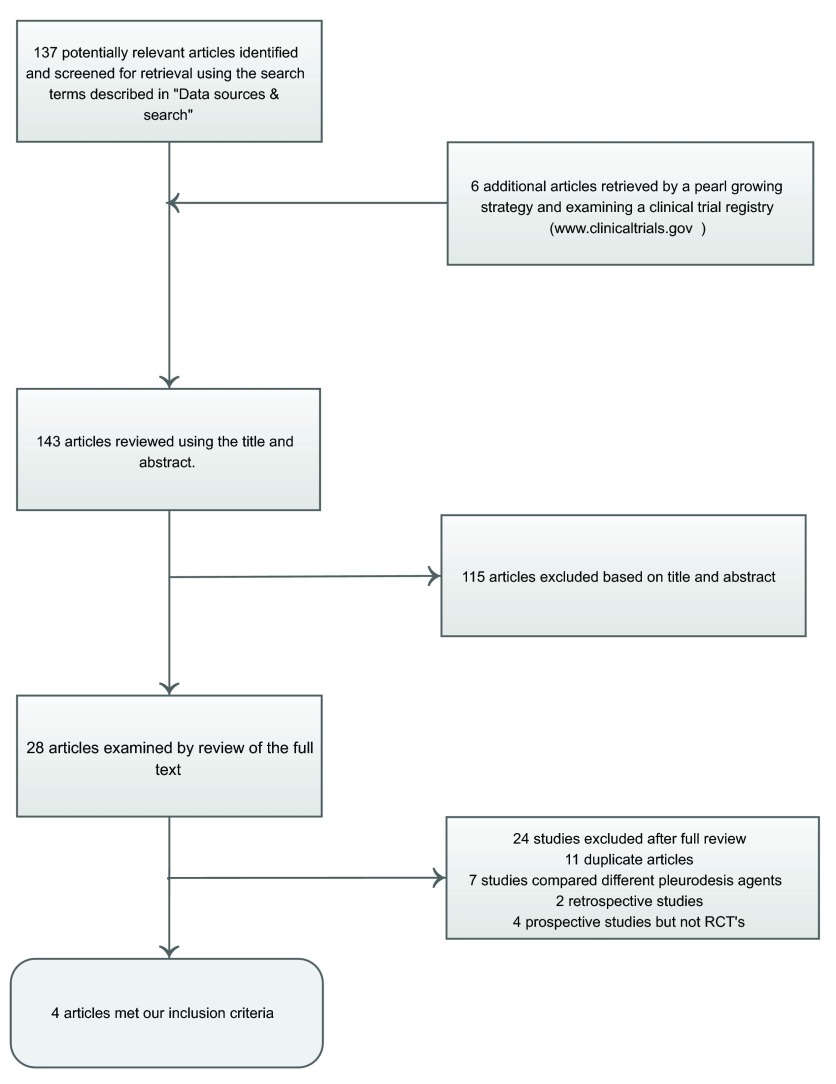
Flowsheet of study selection process.